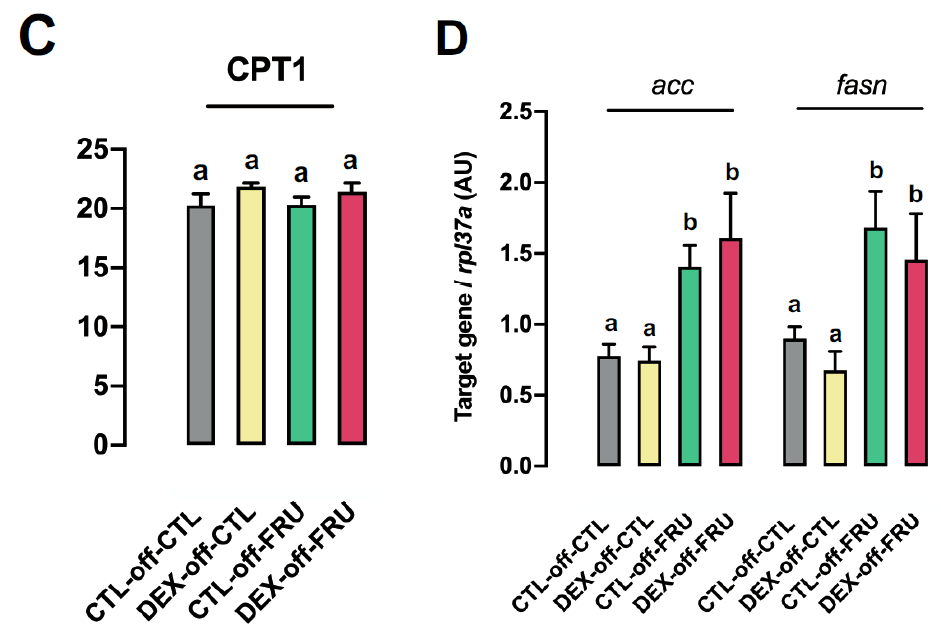
Figure 4. Effects of fructose on hepatic enzyme activities associated with nonesterified fatty acids (NEFA) levels in rats exposed to DEX in utero. The activities of ( A ) citrate synthase (CS), ( B ) glucose 6-phosphate dehydrogenase (G6PDH), and ( C ) carnitine palmitoyltransferase (CPT1) were measured in fragments of liver from the CTL-off-CTL, DEX-off-CTL, CTL-off-FRU, and DEX-off-FRU groups. ( D ) Expression of fasn and acca in liver fragments, as determined by qPCR. The results are presented as the mean ± SE. Means with different superscript minuscule letters are significantly different. The p values are provided in Section 3. N = 10 ‒ 12.